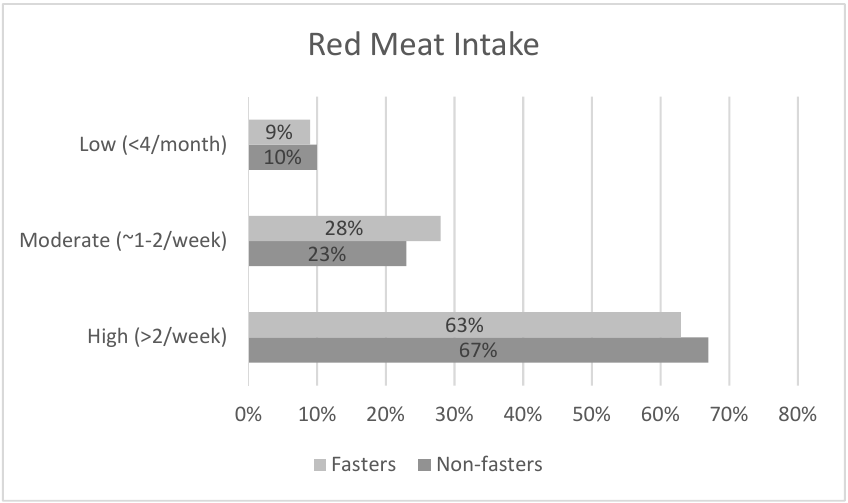
Figure 3. Bar chart for total red meat consumption between fasters and non-fasters. Table 4 shows the breakdown of each red meat product; beef was consumed the most frequently, followed by pork. No significant associations were found between fasting status and total red meat (Chi squared 1.04, p = 0.594), or pork and beef ( p > 0.05). A significant association was found between fasting status and lamb/goat (Chi squared 4.337, p = 0.037), however in both fasters and non-fasters overall consumption was low. Table 4. Results for red meat